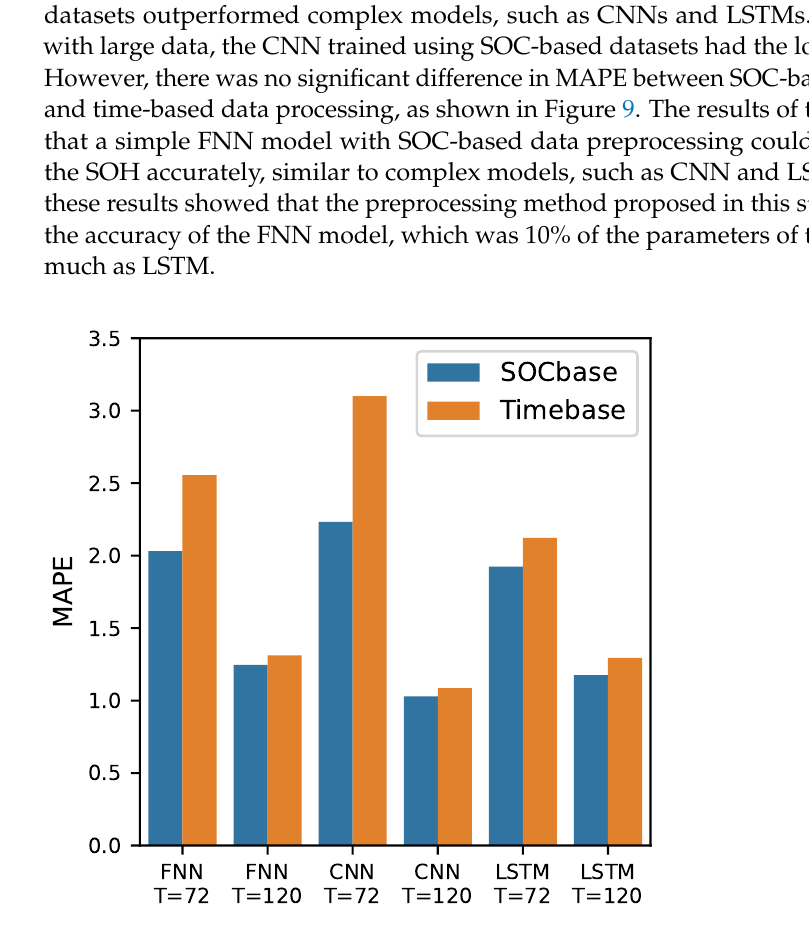
Figure 9. MAPE in various models and training